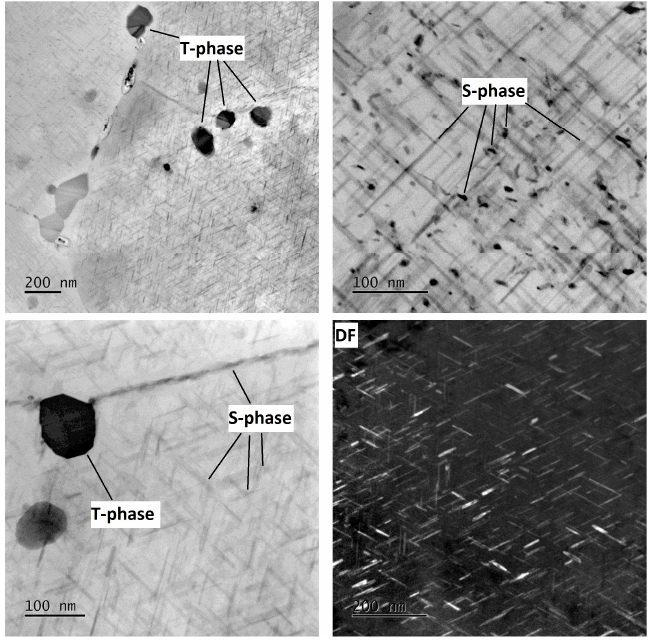
Figure 14. Micrographs of specimen W-1RS-180 at different magnification with marked T-phases and S-phases.